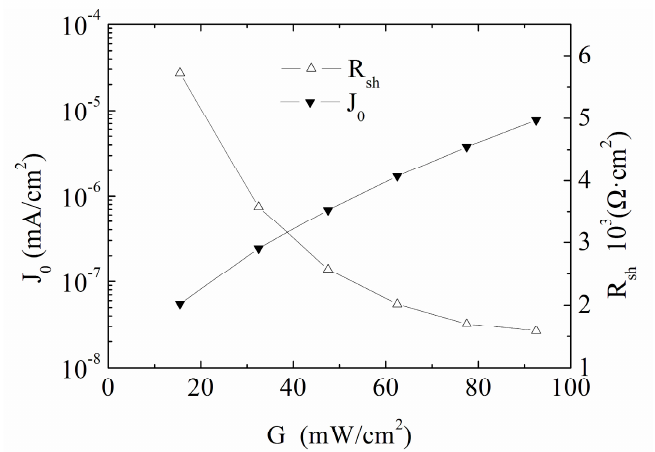
Figure 8. Intensity G versus J 0 and R sh for the CdTe solar cell #2 under low intensity illumination condition.